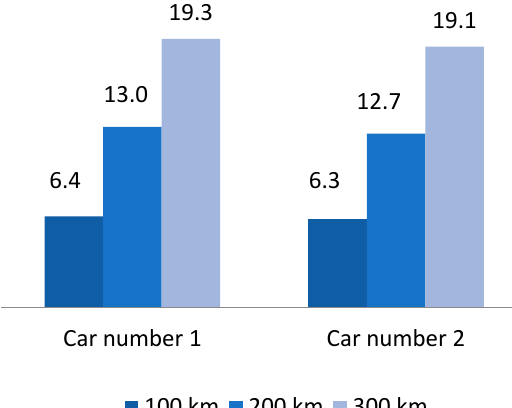
Figure 6. Fuel consumption of cars.